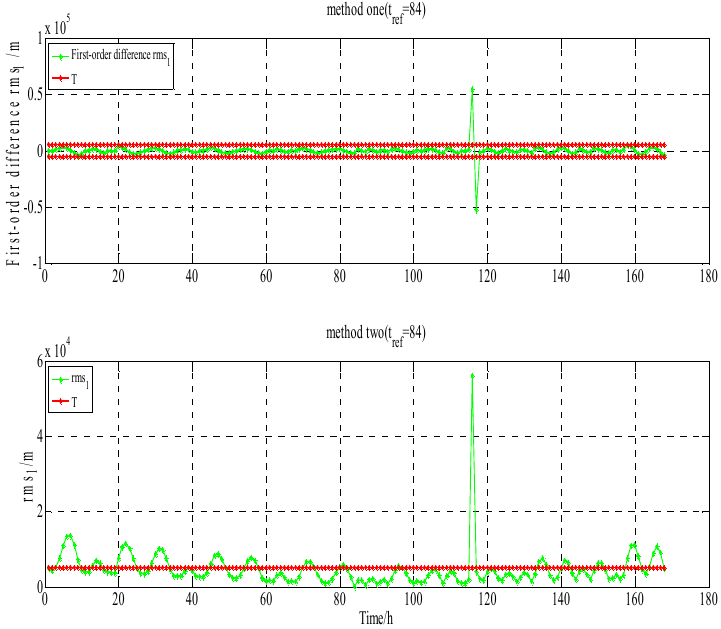
Figure 12. The results for method one( ∇ rms